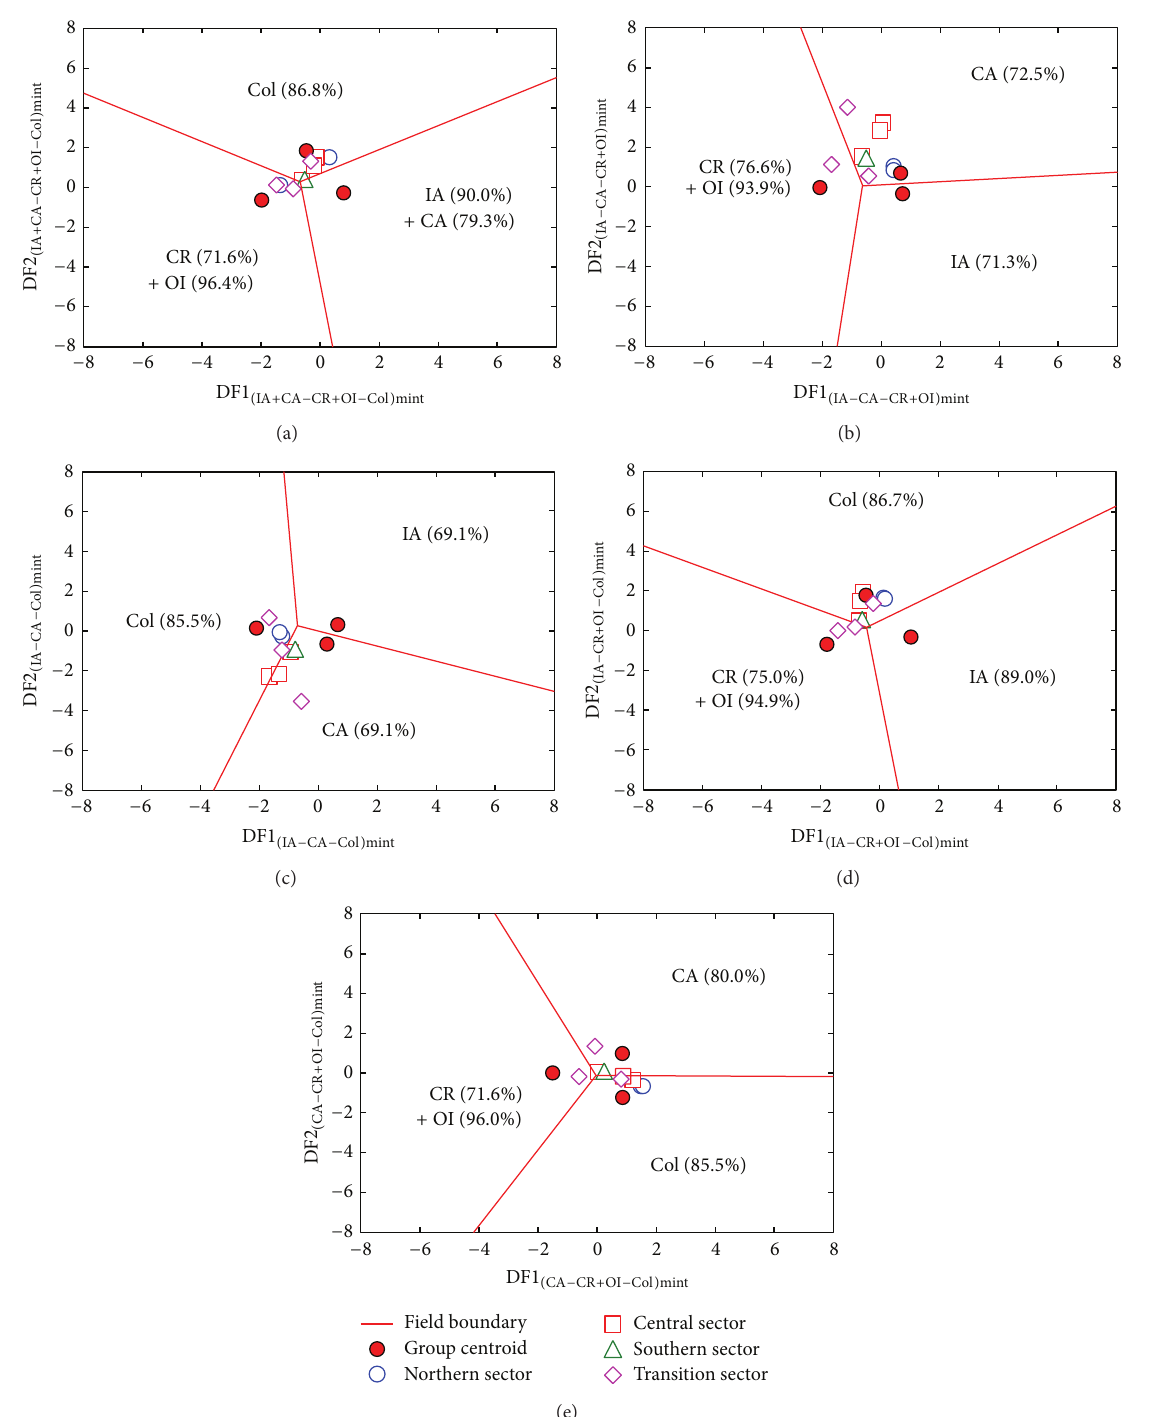
Figure 3: Discriminant-function multidimensional diagrams [21], based on ln-transformed ratios of major elements, for the tectonic discrimination of intermediate Sierra de las Cruces rocks. Tectonic settings: IA: island arc, CA: continental arc, CR: continental rift, OI: ocean island, and Col: collision. The symbols are explained as inset in (a). In (a), five groups are represented as three groups by combining IA and CA as IA + CA and CR and OI as CR + OI. The other four diagrams ((b)–(e)) are for three groups at a time. The subscript mint refers to the set of multidimensional diagrams based on ln-transformed major element (m) ratios for intermediate (int) magmas. Filled circles display the compositional centroid for each tectonic setting. The percentages in each field are the discrimination effectivity. The thick lines represent equal probability discrimination boundaries in all diagrams. The coordinates of the field boundaries and additional information are reported in